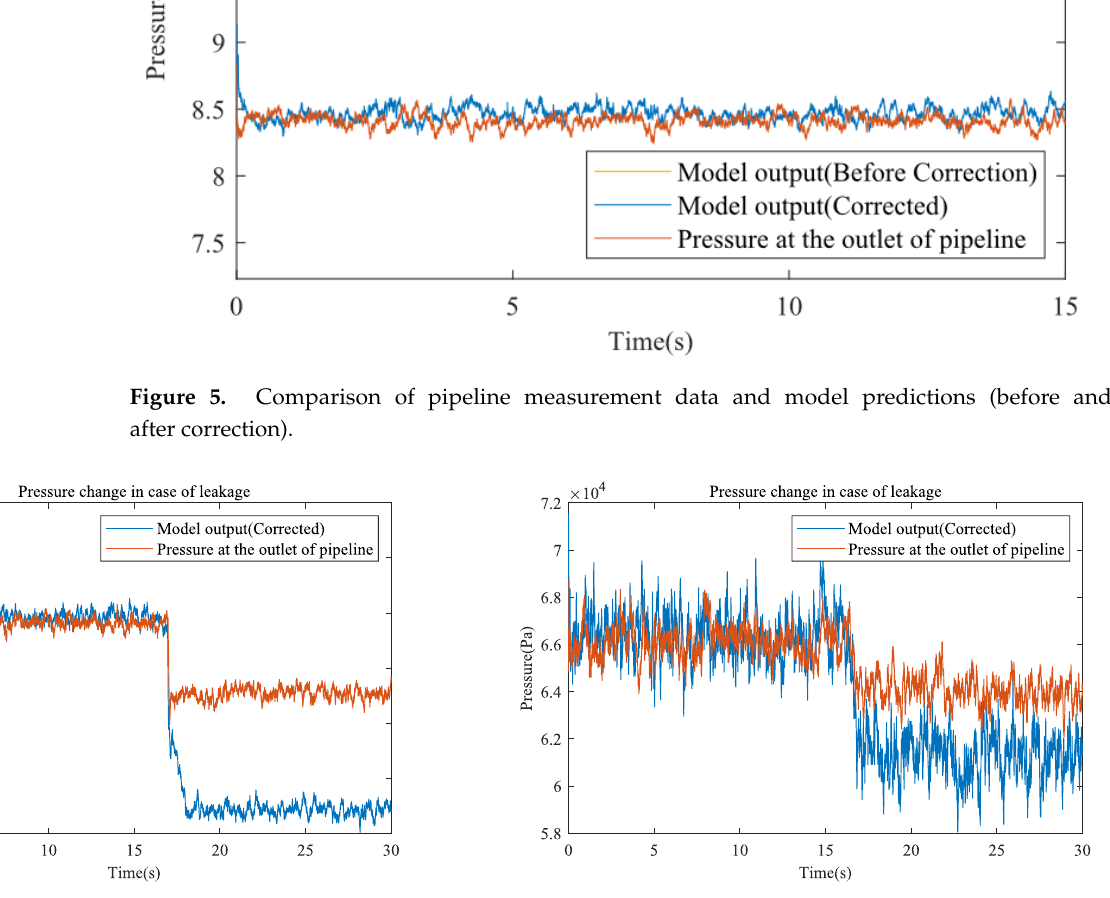
Figure 5. Comparison of pipeline measurement data and model predictions (before and after cor- rection).